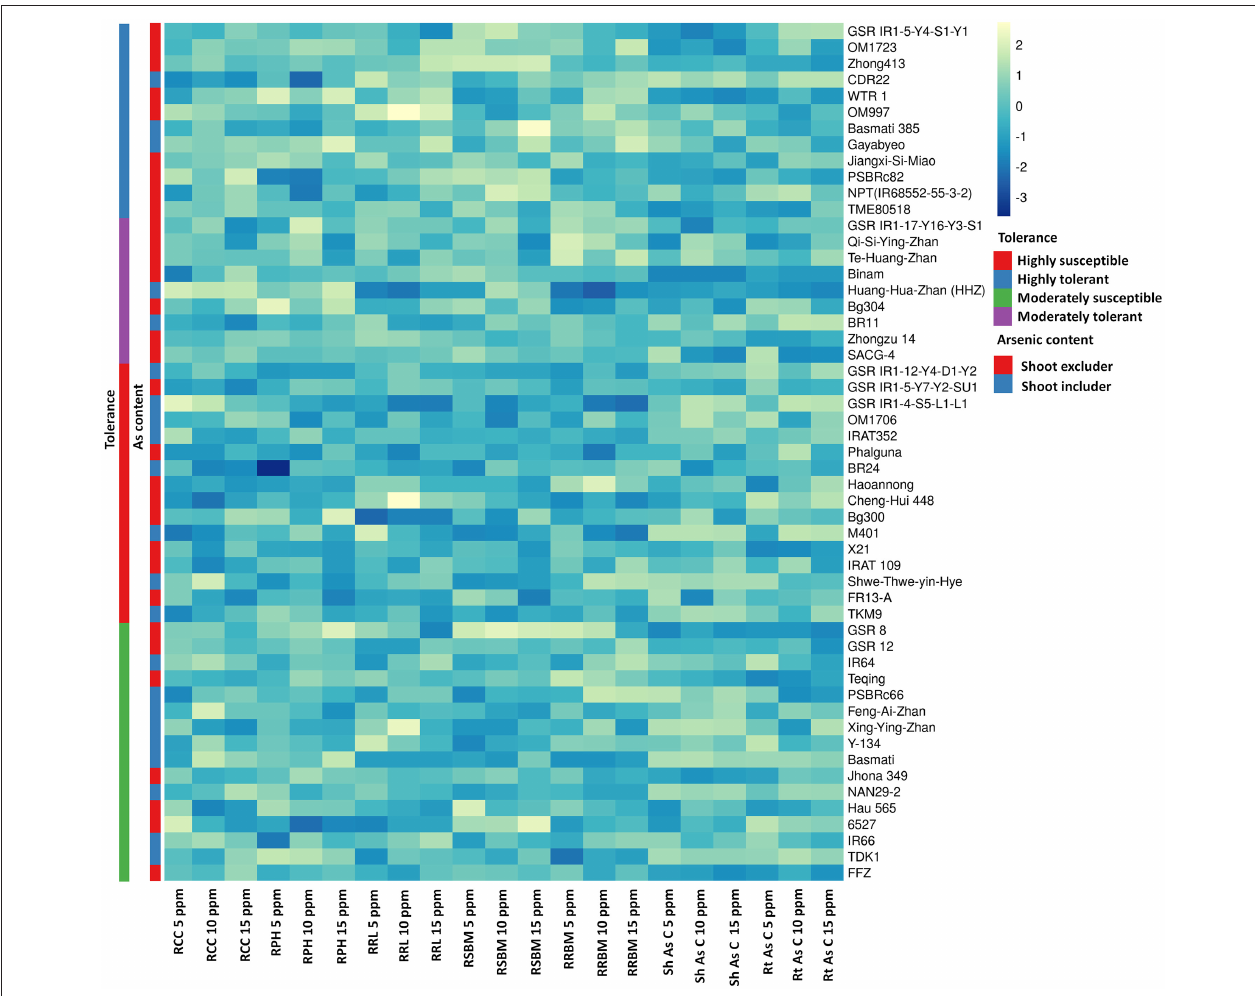
FIGURE 3 | Grouping of 53 cultivars of rice ( Oryza sativa L.) for traits associated with carcinogenic arsenic (As) toxicity stress for 18 days. As, arsenic; PPM, parts per million; RCC, relative chlorophyll content; RPH, relative plant height; RRL, relative root length; RSBM, relative shoot biomass; RRBM, relative root biomass; ShAsC, As content in shoots; RtAsC, As content in